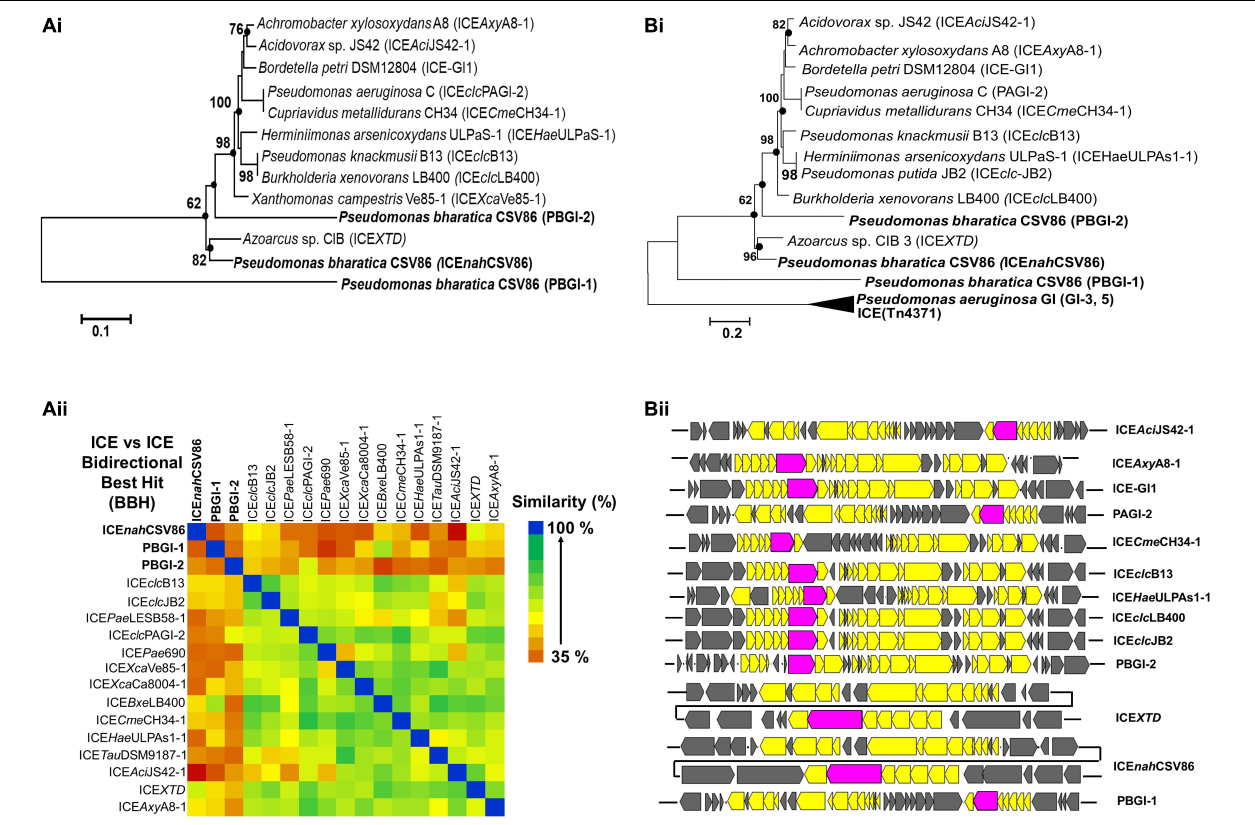
FIGURE 3 | Evolutionary inferences and overall ICE related indices for three GIs, predicted to be ICEs from Pseudomonas bharatica CSV86 T . [A (i)] Neighbor-joining (NJ) phylogenetic tree reconstructed using full-length nucleotide sequences of predicted ICEs and its nearest similar ICEs, and [A (ii)] Heat-map depicting bidirectional best hit-based average nucleotide identity (DNA–DNA homology level) of compared ICEs. [B (i)] Maximum-likelihood (ML)-based phylogeny of concatenated amino acid sequences of core gene modules (T4SS, T4CP), and [B (ii)] structural arrangement of core gene modules of various compared ICEs shown in [B (i)] . Trees were generated with 1,000 bootstrap iterations and the values at each node are represented as percentage replicates. The black solid circles represent generation of trees from all tree-making algorithms (NJ, ML, and